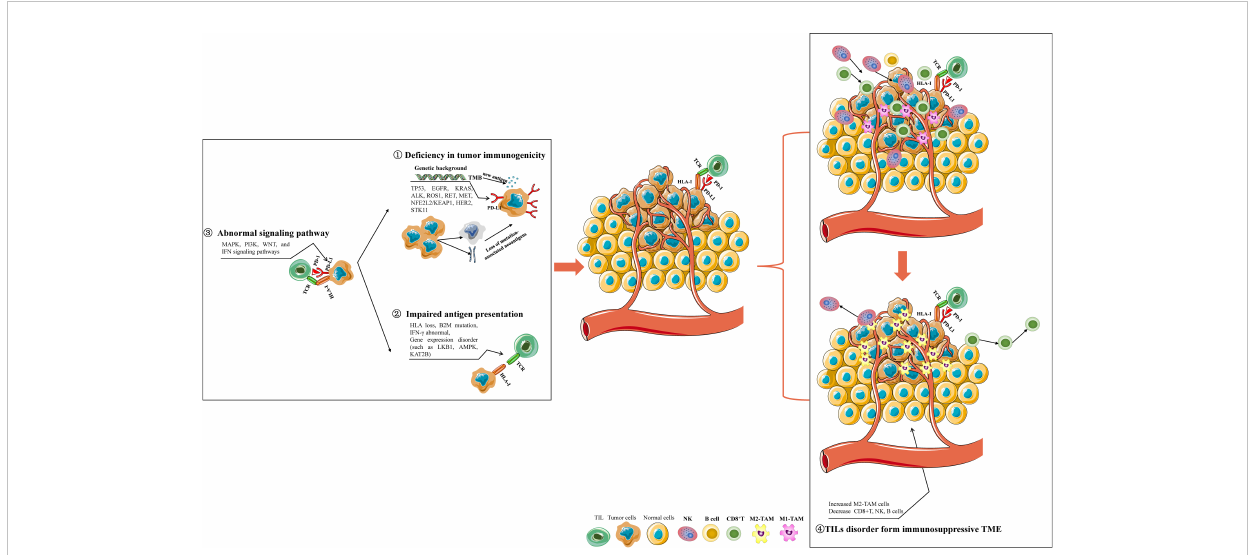
FIGURE 4 The mechanisms involved in immunotherapy resistance of NSCLC. De fi ciency in tumor immunogenicity: various drive gene mutations affect PD-L1 expression, TMB, and tumor-speci fi c neoantigen formation; Impaired antigen presentation: HLA loss, B2M mutation, IFN- g signaling dysregulation, and some genes disorder; Abnormal signaling pathway: abnormal MAPK, PI3K, WNT, and IFN signaling pathways may in fl uence tumor immunogenicity and antigen presentation; Abnormal activity and in fi ltration of immune cells in NSCLC TME: NSCLC TME enriched with increased M2 macrophages, decreased B cells, and NK cells form an immunosuppressive TME to resist the initiation of antitumor immunity. Some gene expression disorders or mutations in NSCLC cells can impair the activity, tumor-cell-killing function, proliferation, and in fi ltration of CD8+ T-cells in TME, which contribute to exhausted CD8+ T-cells for immunotherapy